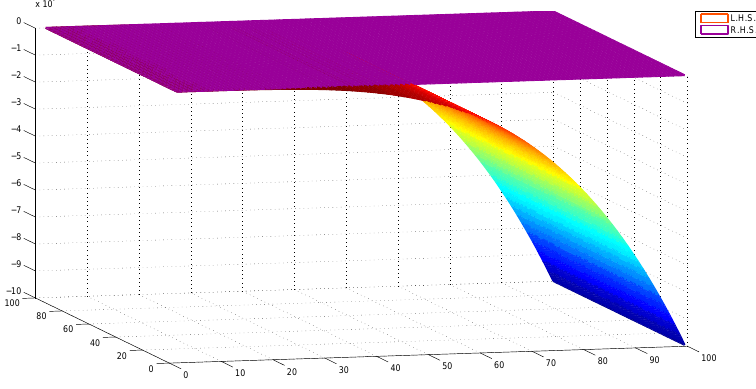
Figure 1. The value of comparison of L.H.S. and R.H.S. of (4) in 2D view.